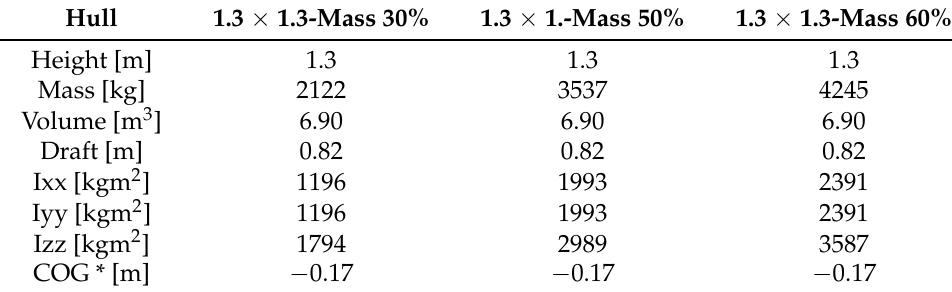
Table 5. Configuration parameters of hull mass sensitivity analysis.